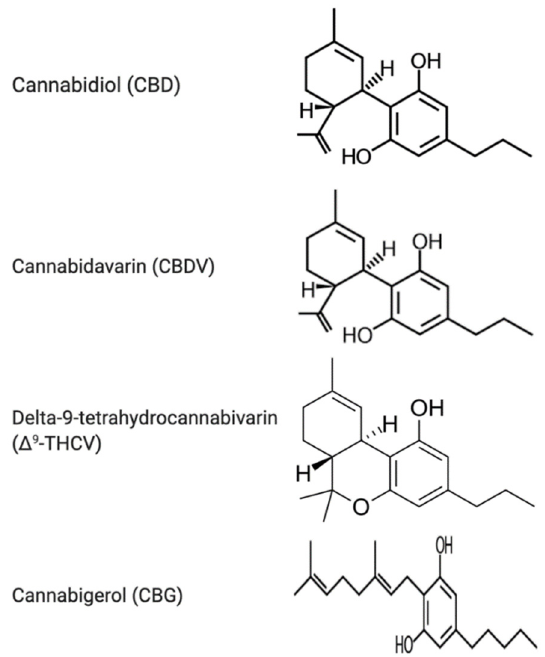
Figure 1. Chemical structures of the phytocannabinoids cannabidiol (CBD), cannabidavarin (CBDV), delta-9-tetrahydrocannabivarin ( ∆ 9 -THCV) and cannabigerol